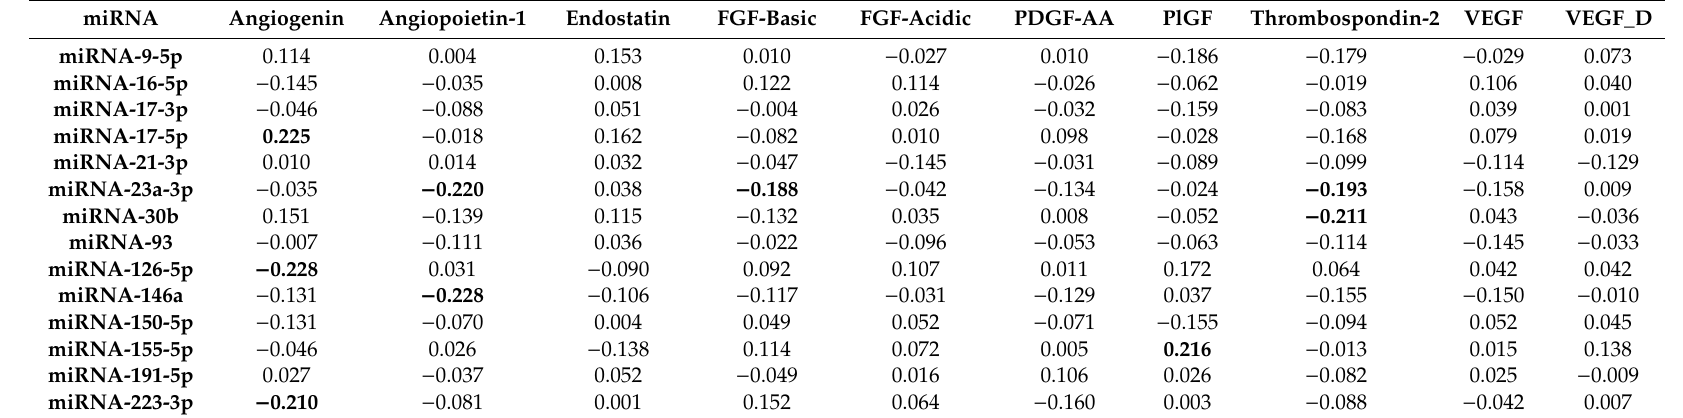
Table 5. Spearman’s correlation coe ffi cients for plasma miRNAs and angiogenesis-regulating factors in